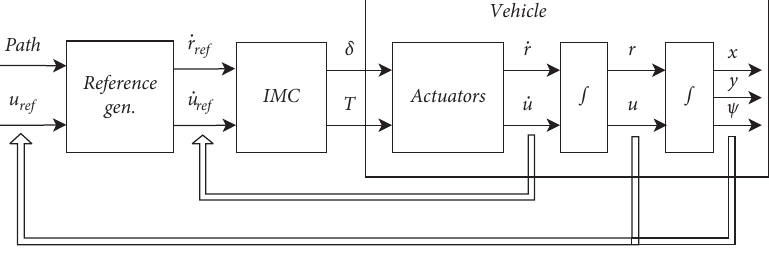
Figure 2: Cascade controller structure.